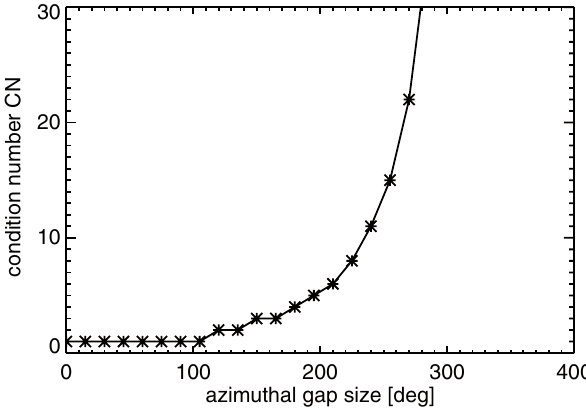
Figure 3. Condition number (CN) vs. azimuthal gap size for a VAD scan with 15 ◦ intervals of azimuth α and a constant elevation angle ε = 75 ◦